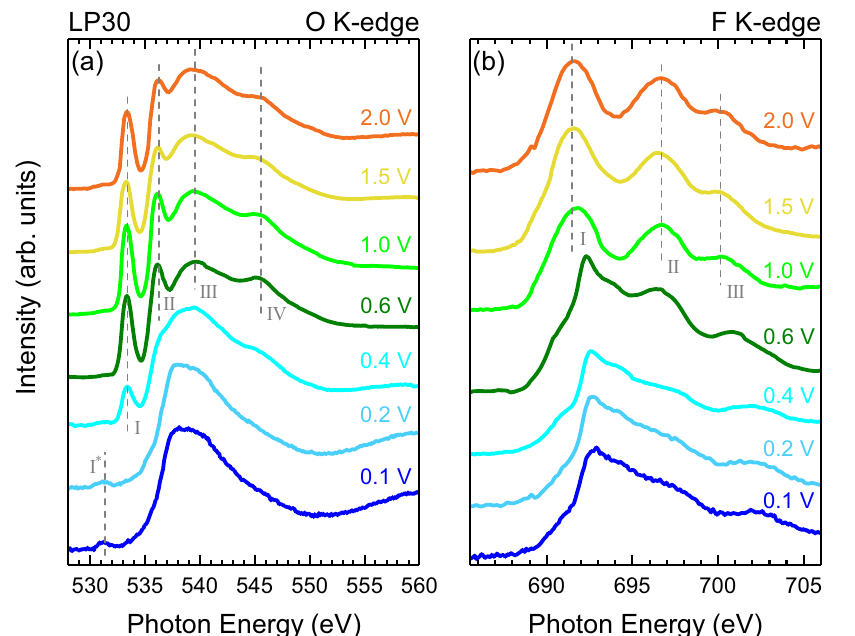
Fig. 3 | Operando TEY-XAS without any additives. TEY XAS of( a ) the O K-edge and ( b ) F K-edgetaken during cycling atdifferent potentials ranging from 2.0V down to 0.1V, for a cell containing LP30 electrolyte without any